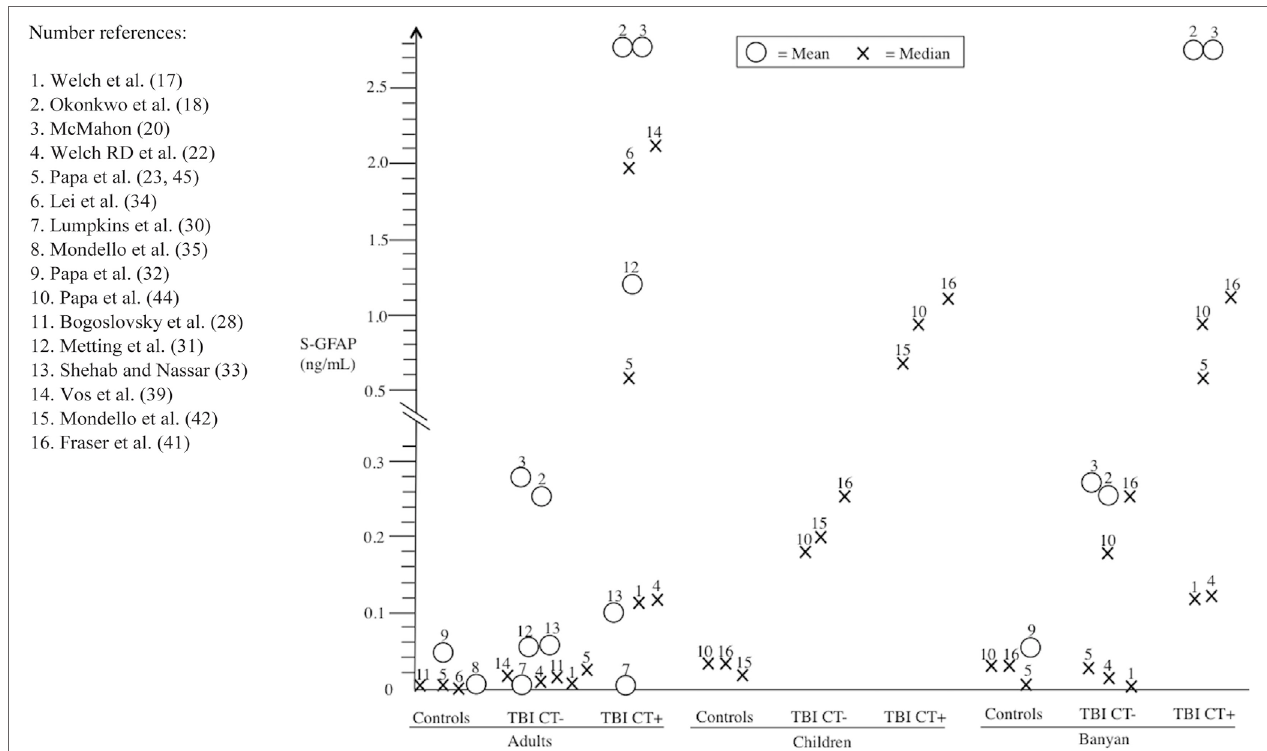
FiGURe 2 | Serum glial fibrillary acidic protein (GFAP) findings (means and medians) from individual studies stratified into different subgroups: (i) controls, (ii) CT-negative traumatic brain injury (TBI) (TBI CT − ), and (iii) CT-positive TBIs (TBI CT + ). For comparison, the findings are subdivided into adult and pediatric subpopulations, and also results of the most commonly used Banyan Biomarkers (Banyan Biomarkers, Inc., Alachua, FL, USA) assay are presented